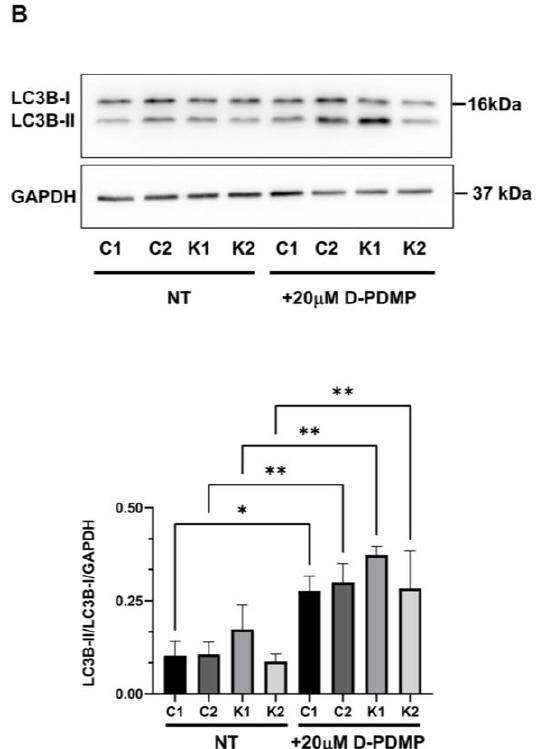
Figure 5. ( A ) Cell sphingolipid analysis performed in growth condition (NT) and after 4 h in EBSS plus 20 µM CQ. Statistical significance was determined through one-way ANOVA and Bonferroni’s multiple comparisons ( n = 2). *: p < 0.05; **: p < 0.01; ***: p < 0.001; ****: p < 0.0001. SM: sphingomyelin; Cer: ceramide; DHCer: dihydroceramide; Gb3: globoside 3; HexCer: hexosylceramide; LacCer: lactosylceramide. ( B ) Representative Western blot LC3B-I and LC3B-II proteins in growth conditions (NT) and after treatment with 20 µM D-PDMP for 24 h. Densitometric analysis of LC3B-II/LC3B-I ratio. Data are mean ± SD of independent experiments ( n = 3). Statistical significance was calculated by one-way ANOVA and Tukey’s multiple comparisons tests *: p < 0.05; **: p < 0.01. C1: Control 1 fibroblasts; C2: Control 2 fibroblasts; K1: Krabbe 1 fibroblasts; K2: Krabbe 2 fibroblasts. NT: non-treated.